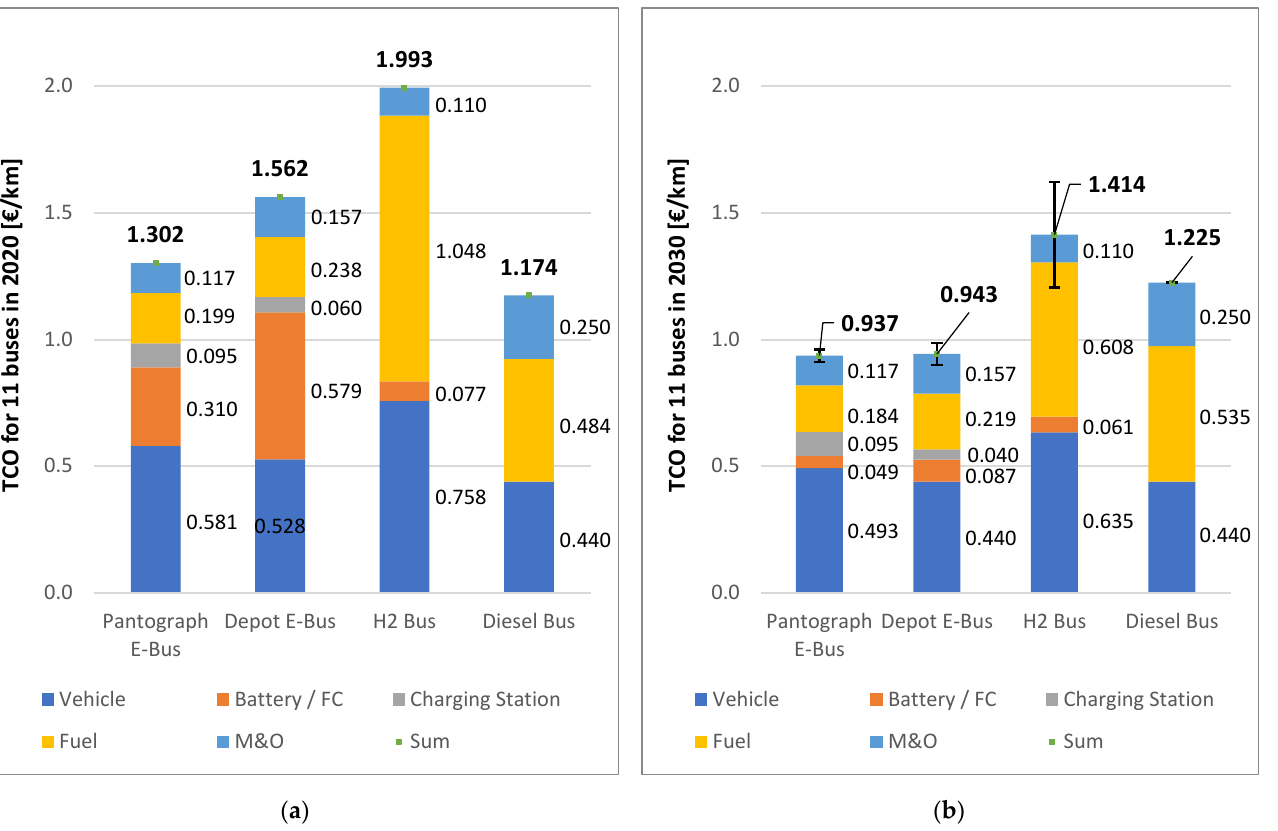
Figure 14. TCO estimations for 11 buses scenario: ( a ) in 2020; ( b ) in 2030 with the sensitivity analysis of battery prices for e-buses and hydrogen costs for fuel cell bus in 2030 results.